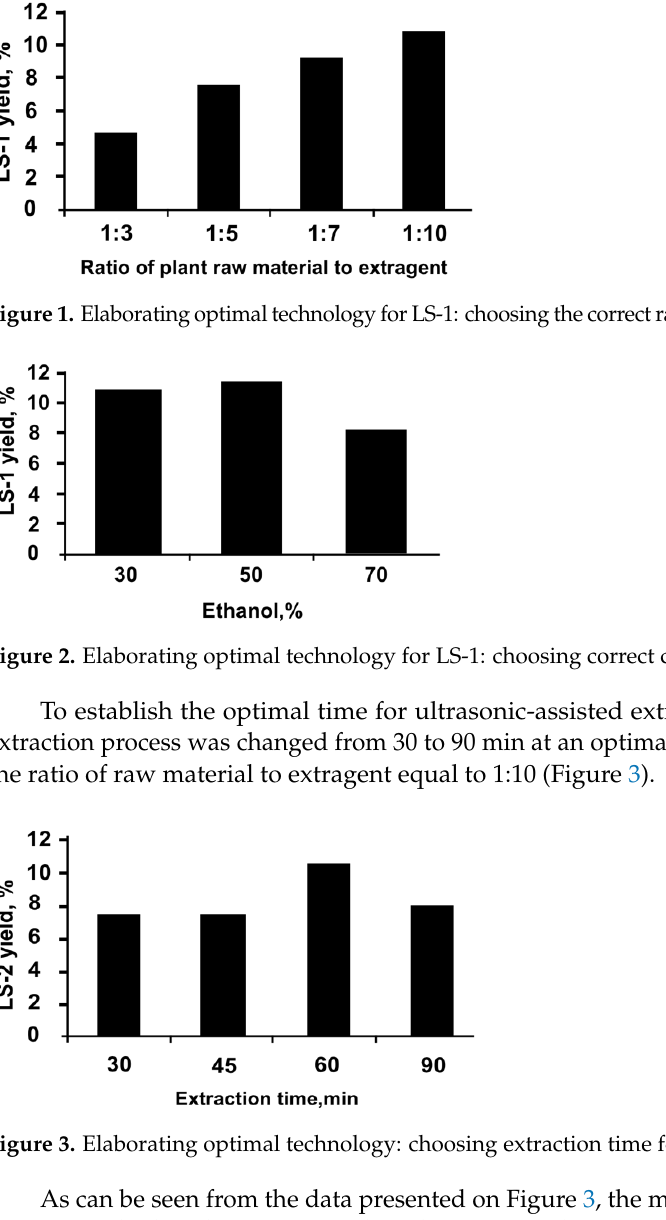
Figure 3. Elaborating optimal technology: choosing extraction time for LS-2.